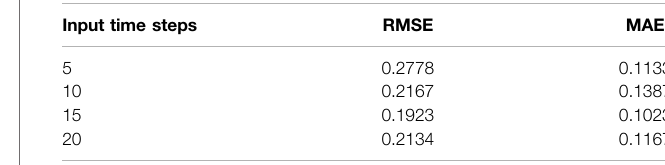
TABLE 1 | Prediction performance of different input step